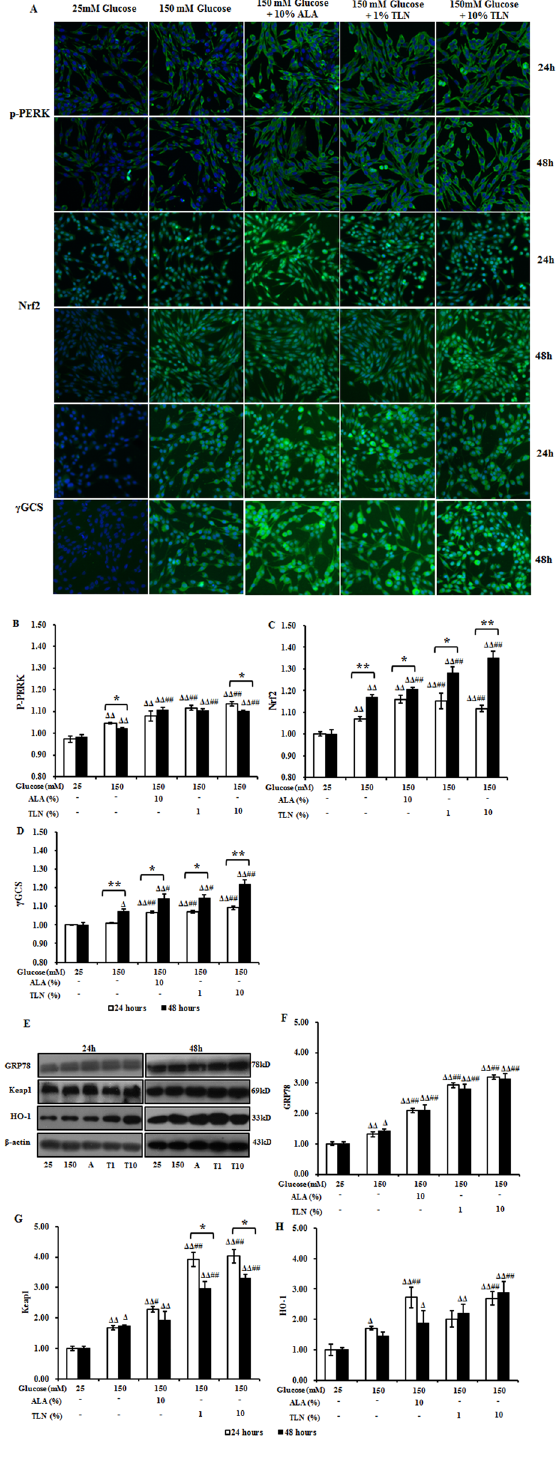
Figure 4. Expression of proteins in the PERK/Nrf2 pathway in RSC96 cells treated with TLN and exposed to high glucose. ( A ) High content analysis of p-PERK, Nrf2 and γ GCS at 24 and 48 h. Images show immunostaining of RSC96 cells (10 × magnification). ( B – D ) Fold changes of p-PERK, Nrf2 and γ GCS levels relative to these after 25 mM glucose treatment. ( E ) Representative Western blots of GRP78, Keap1 and HO-1 in RSC96 cells 24 and 48 h. ( F – H ) Relative protein levels of GRP78, Keap1 and HO-1 against of β -actin. Data are represented as the means ± S.E.M. Δ P < 0.05, ΔΔ P < 0.01 vs. 25 mM glucose groups; # P < 0.05, ## P < 0.01 vs. 150 mM glucose groups; * P < 0.05, ** P < 0.01 vs. treated after 24 hours. Data were analyzed by One-way ANOVA followed by least significant difference or Tambane’s T2 analysis and Student’s unpaired t-test compared to 24 hours’ time point. (n = 4 per